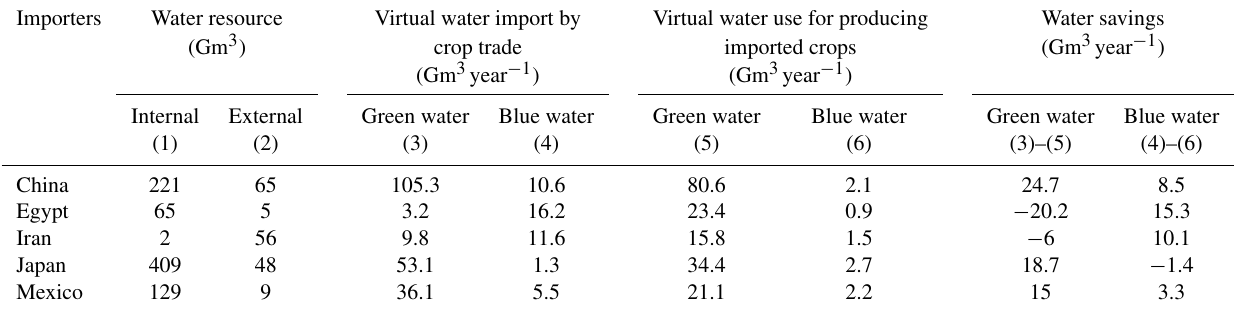
Table 4. Water resource and virtual water savings by importing crops.